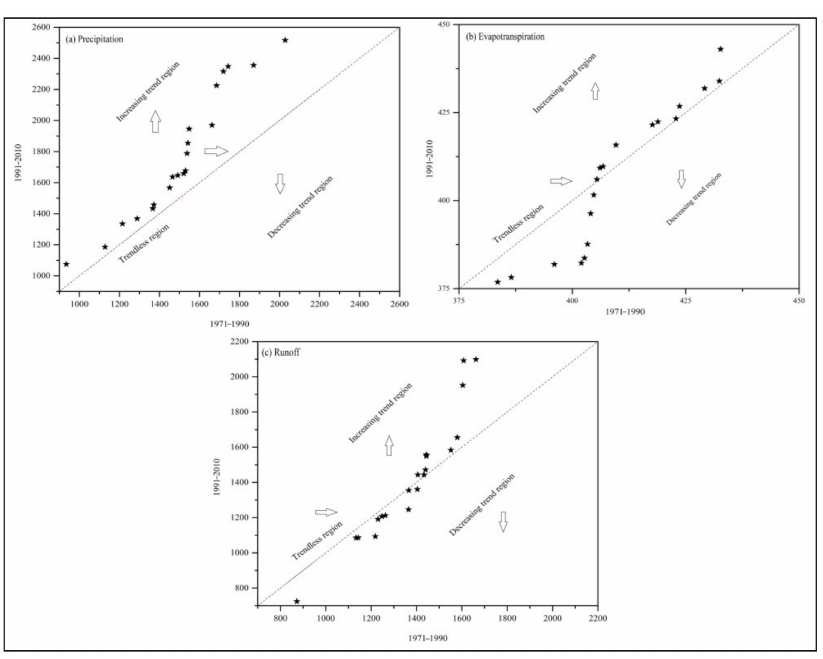
Figure 7. ITA of precipitation, evapotranspiration, and runoff time series of the KRB. ( a ) Precipitation; ( b ) Evapotranspiration; ( c )